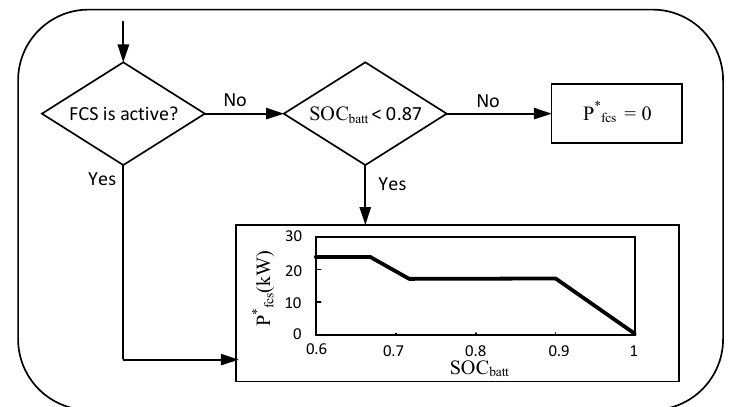
Figure 11. Charge-Balancing EMS [28].